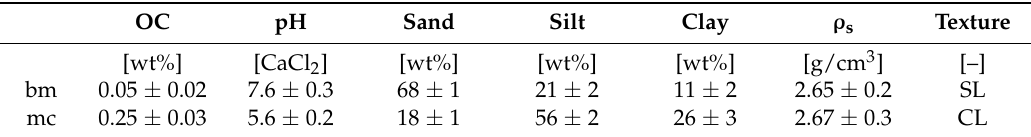
Table 1. Soil characteristics of boulder marl (bm) and marsh clay (mc) with 4 replicate measurements for organic carbon (OC), pH value, texture, and particle density ( ρ s ), respectively. The symbol ± indicates the standard deviation. SL, CL = [11].